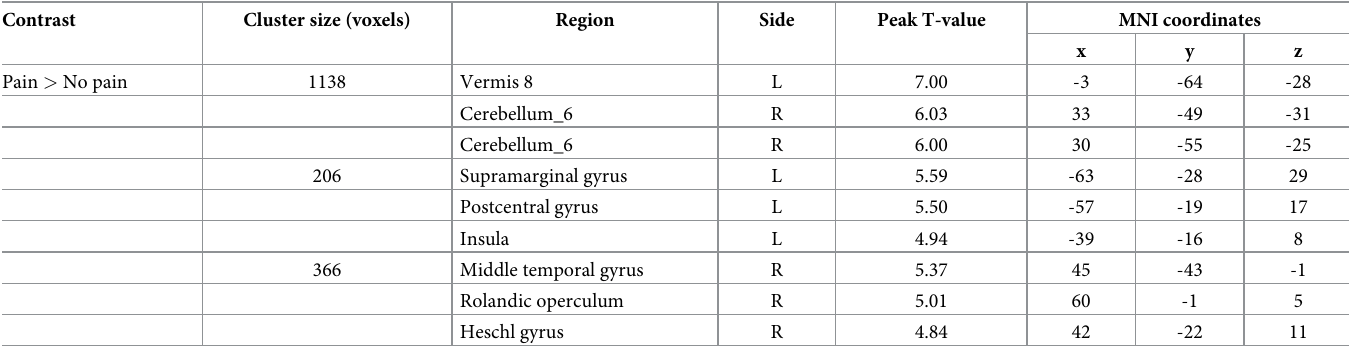
Table 4. Activation changes to painful and non-painful stimulation (N = 23). Contrast Cluster size (voxels) Region Side Peak T-value